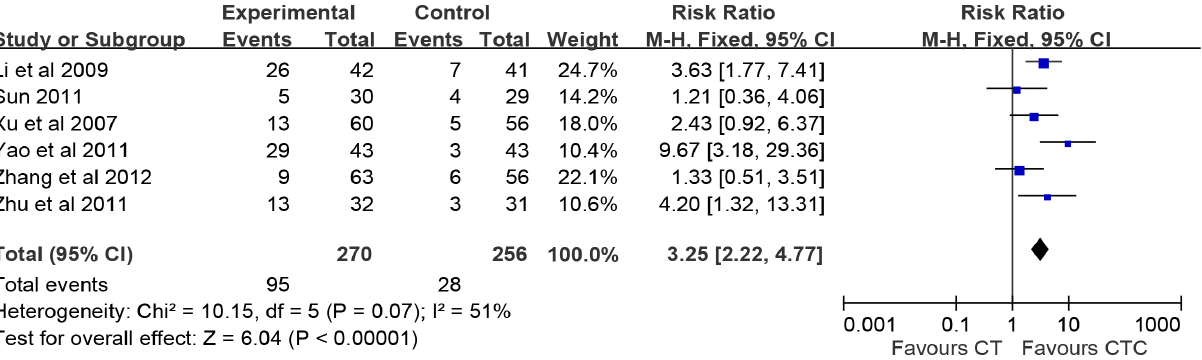
Figure 4. Quality of life. The quality of life changes on Karnofsky performance scale (KPS) were estimated from meta-analysis of pairwise comparisons in patients with Chinese herbal medicine (CTC, treatment group) versus patients in chemotherapy (CT, control group). KPS improvement (the increase of KPS $ 10).